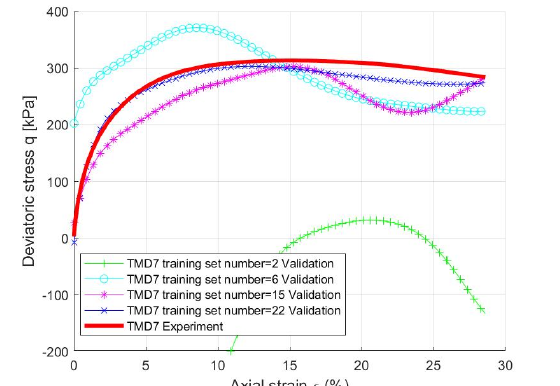
Fig. 2 Deviatoric stress q versus axial strain ε 1 in drained monotonic triaxial tests ( I D0 = 0.51 and p 0 = 100